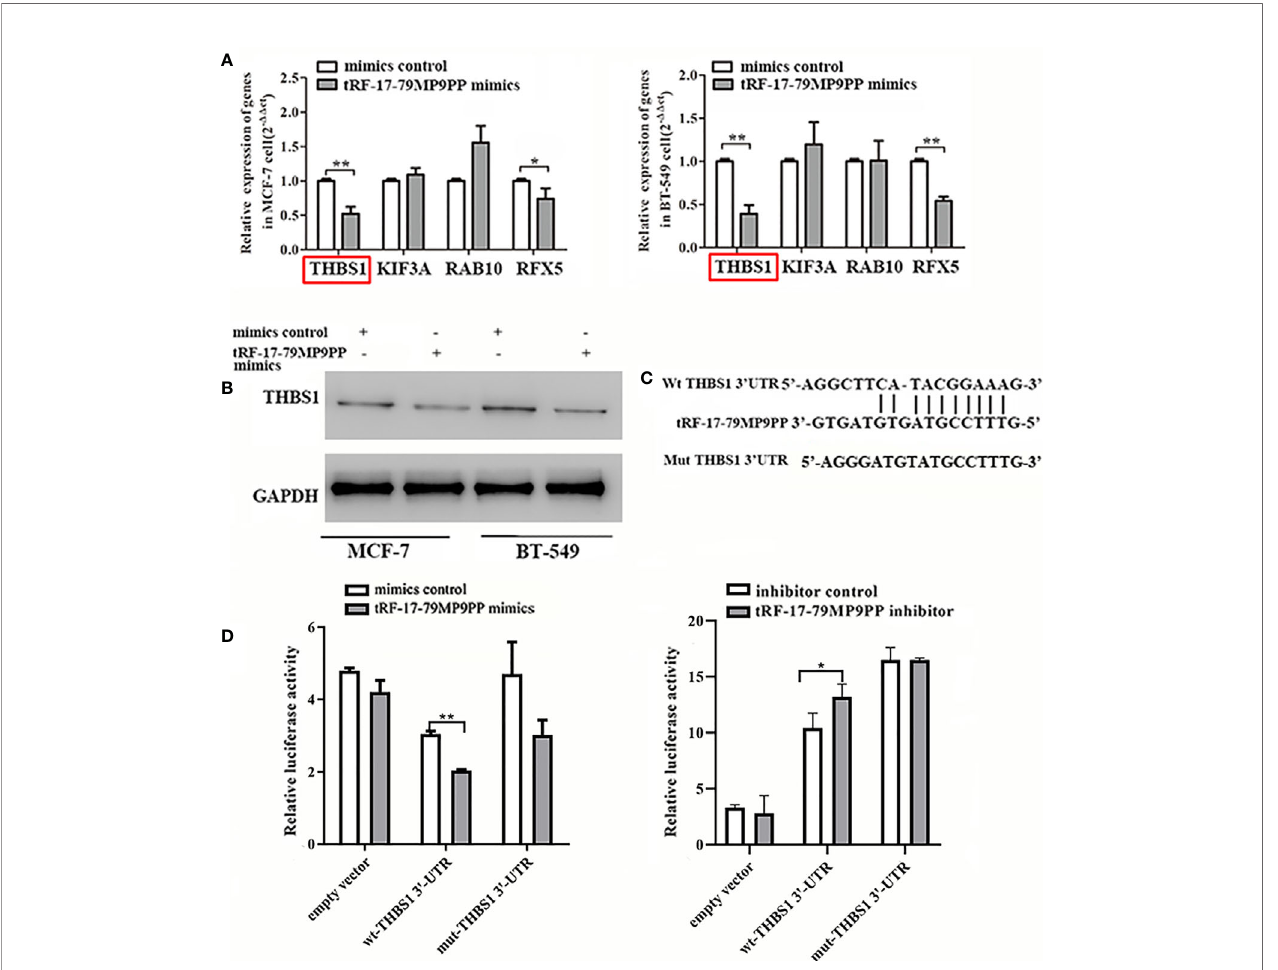
FIGURE 5 | tRF-17-79MP9PP directly regulates THBS1 expression in breast cancer cells. THBS1 mRNA (A) and protein (B) levels expression in treated MCF-7 and BT549 cells, respectively. (C) 3 ’ -UTR fragment of wide-type (wt) and mutated which disrupted interaction with tRF-17-79MP9PP. (D) The wt or mutated reporter plasmid was co-transfected with tRF-17-79MP9PP mimics/inhibitor and negative control into HEK293T cells. Luciferase activity of wt THBS1 3 ’ -UTR was signi fi cantly in fl uenced by tRF-17-79MP9PP in cells. * p < 0.05; ** p < 0.01, statistically signi fi